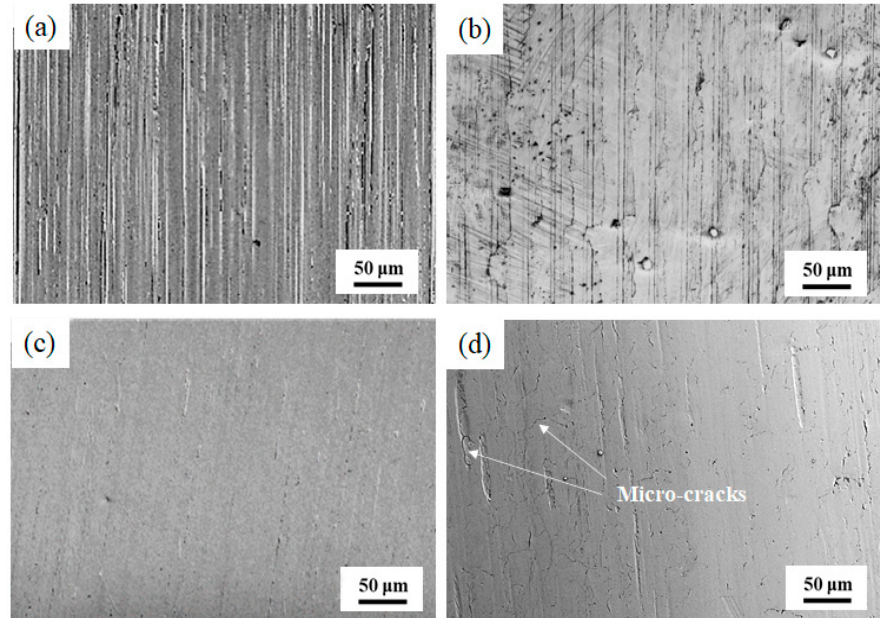
Figure 5. The surface micro-morphology of the grinding processing sample and the sample after SURT with different static pressures. ( a ) The grinding processing sample; ( b ) the sample after SURT with 0.2 MPa; ( c ) the sample after SURT with 0.4 MPa; and ( d ) the sample after SURT with 0.6 MPa.